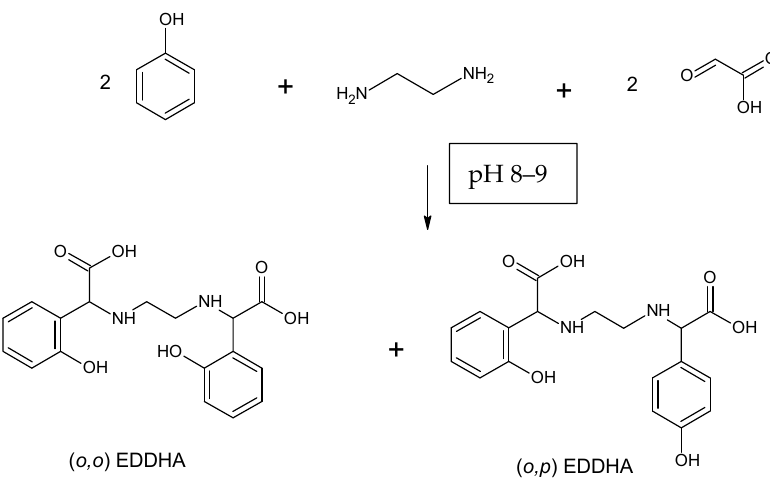
Figure 15. Reaction scheme for the preparation of EDDHA using the Mannich reaction.